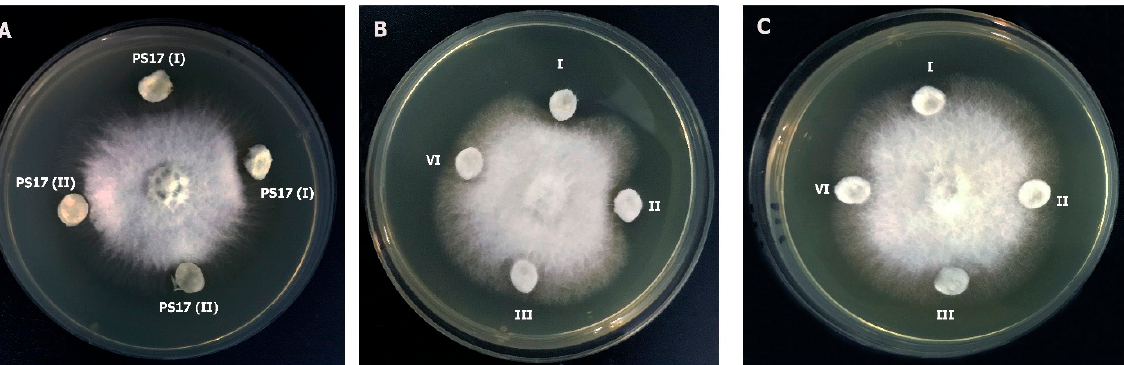
Figure 6. Antifungal activity of the bacterial cell suspension against phytopathogenic V. dahliae ( A ) , F. chlamydosporum ( B ), Fusarium spp. ( C ) , F. solani ( D ), F. graminearum ( E ), and Forl ZUM2407 ( F ).